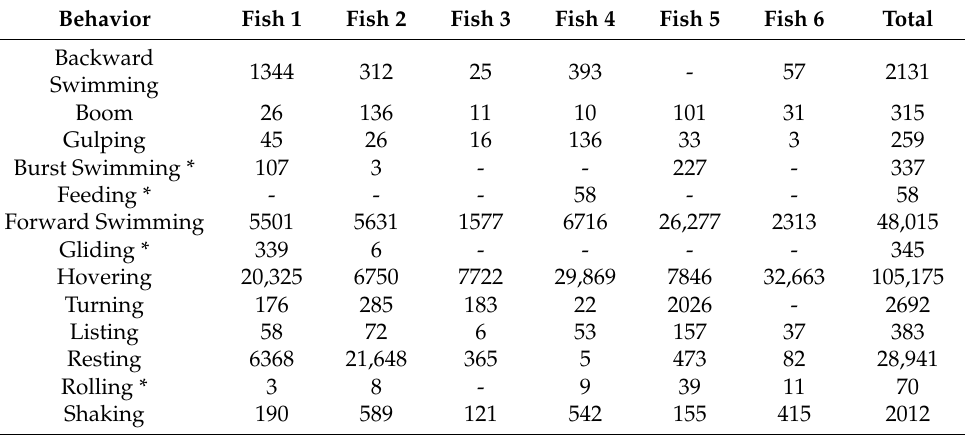
* Indicates classes omitted from